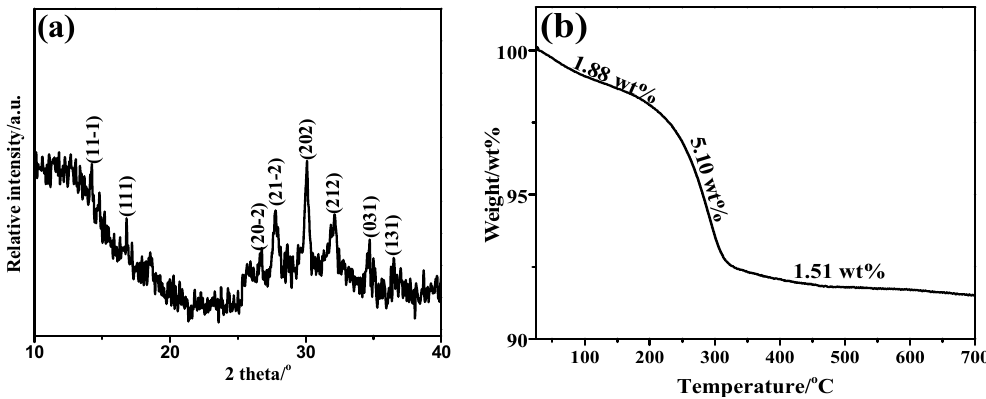
Figure 1. ( a ) XRD pattern of LCPP; ( b ) TGA curve of LCPP.